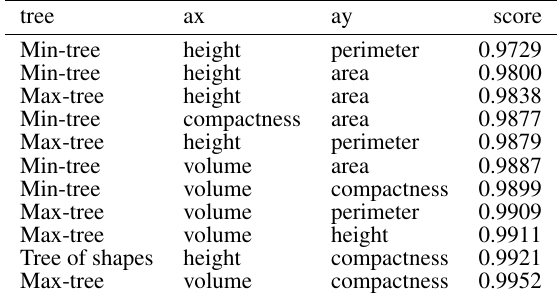
Table 3. 2D spectra intersection of gold panning and